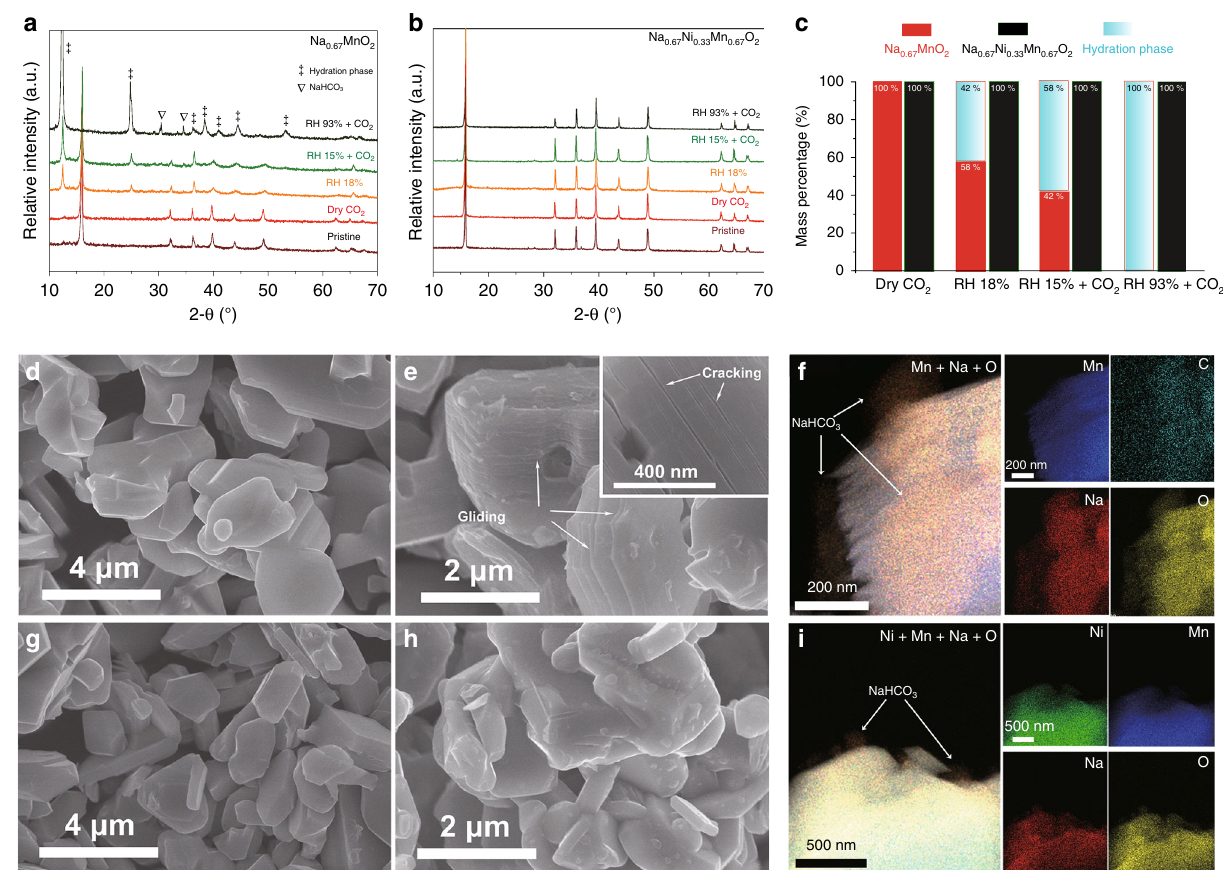
Fig. 2 The structural transitions of P2-Na 0.67 TmO 2 upon air-exposure. The XRD patterns of a Na 0.67 MnO 2 and b Na 0.67 Ni 0.33 Mn 0.67 O 2 samples exposed in different atmosphere. c The re fi nement results of exposed Na 0.67 MnO 2 and Na 0.67 Ni 0.33 Mn 0.67 O 2 samples with a two-phase model. The SEM images of d pristine and e RH 93% + CO 2 exposed Na 0.67 MnO 2 powder, f The EDS mapping results of exposed Na 0.67 MnO 2 , indicating that NaHCO 3 is formed on the particles ’ surface. The SEM images of g pristine and h RH 93% + CO 2 exposed Na 0.67 Ni 0.33 Mn 0.67 O 2 powder. i The EDS mapping results of RH 93%